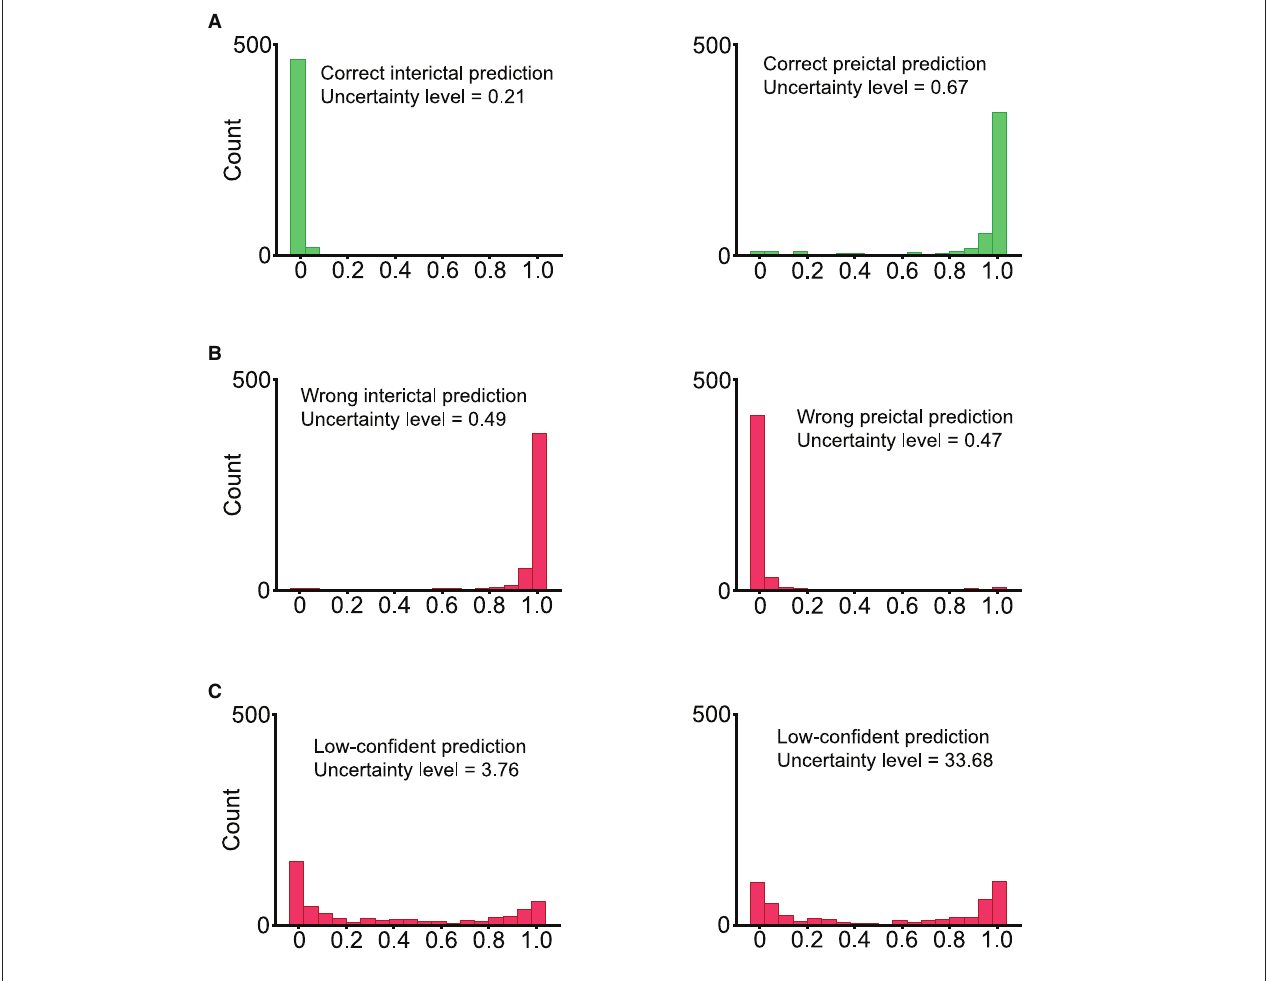
FIGURE 5 | Inference values by sampling the output of Bayesian convolutional neural network 500 times. (A) Correct predictions. Left: ground truth is 0 (interictal), most of the model’s output samples are close to 0, indicating a correct prediction with high confidence. Right: ground truth is 1 (preictal), most of the model’s output samples are close to 1, indicating a correct prediction with high confidence. (B) Wrong predictions. Most of the model’s output samples are close to the wrong value with high confidence. This is an undesirable case. (C) Low-confident predictions with high uncertainty levels. The model’s output samples spread randomly between 0 and 1, indicating the high uncertainty of the model.